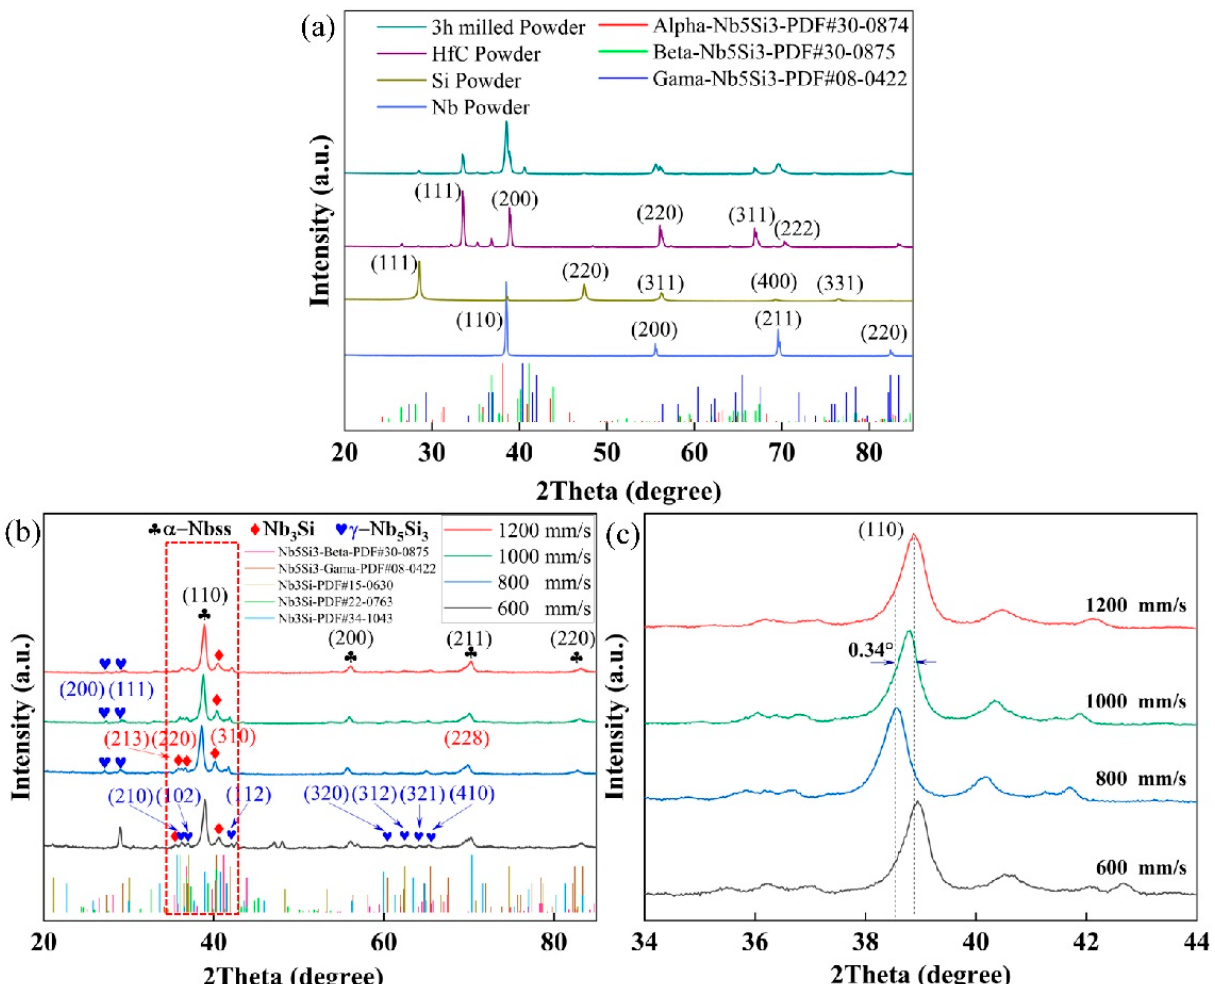
Figure 2. X-ray diffraction patterns of ( a ) powders after 3 h of ball milling; ( b ) component phases present in as-deposited Nb-18Si-5HfC alloys at various scan speeds; ( c ) local magnification of the diffraction peak shift at various scan speeds.